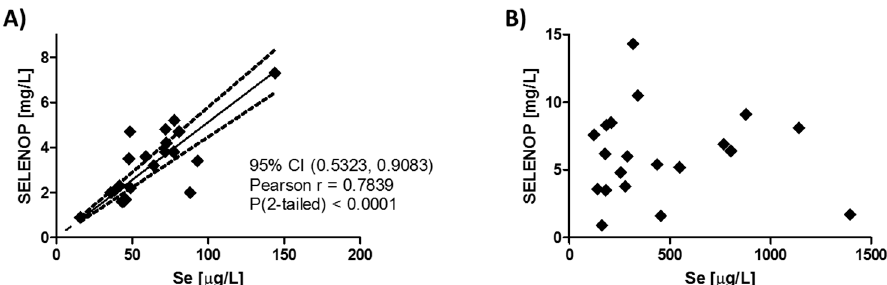
Figure 2. Se status at baseline and after four days of selenite infusion in the SECAR study. ( A ) Plasma Se and selenoprotein P (SELENOP) levels were linearly correlated at baseline, that is, at day 1 before supplementation. ( B ) The two biomarkers of Se status showed no correlation after four daily selenite infusions on day 5. Pearson’s correlation analysis; n = 21 data pairs (left) and 20 data pairs (right), respectively. CI, confidence interval.